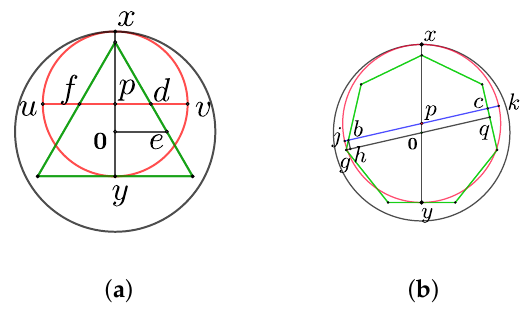
Figure 2. n is odd. ( a ) n = 3; ( b ) n ≥